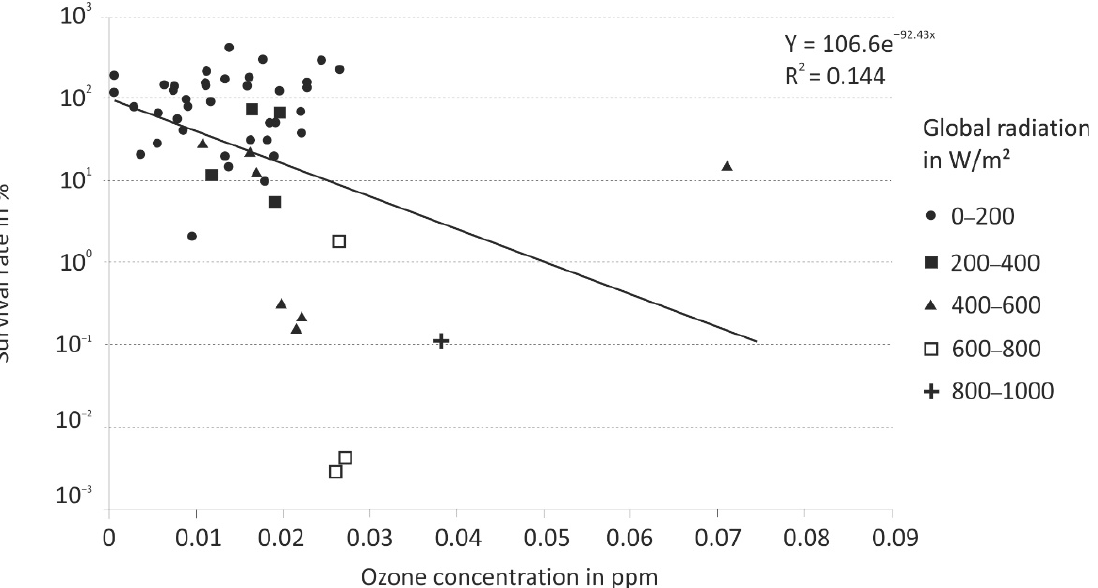
Figure 7. Survival rates of Staphylococcus xylosus after 12 min in the airborne state as a function of relative humidity and the influence of global radiation ( n = 54).